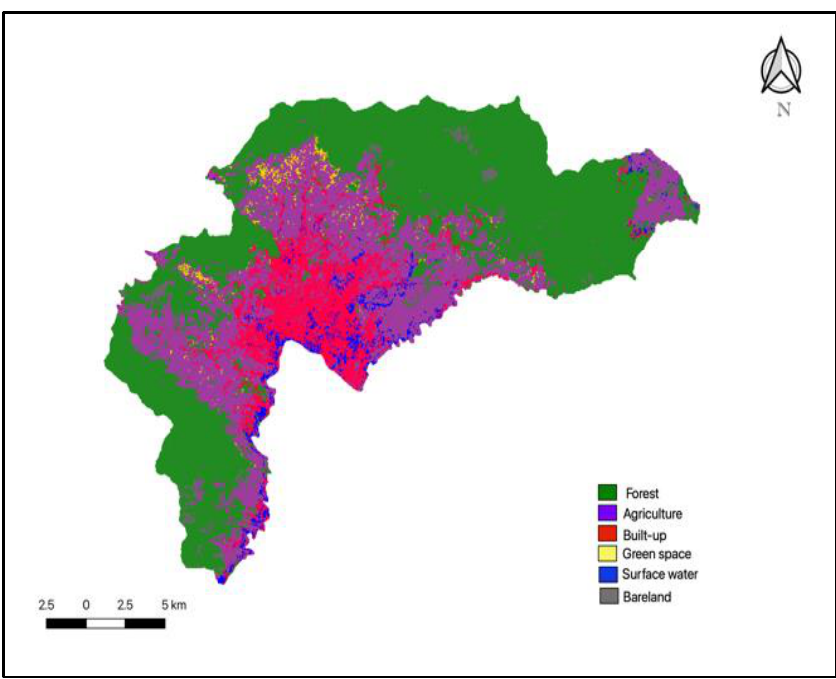
Figure 3. Land cover map of year 2001.